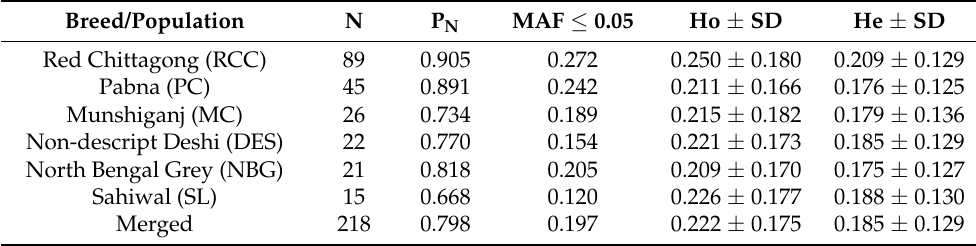
Table 1. Genetic diversity indices for the studied six cattle populations of Bangladesh. Breed/Population